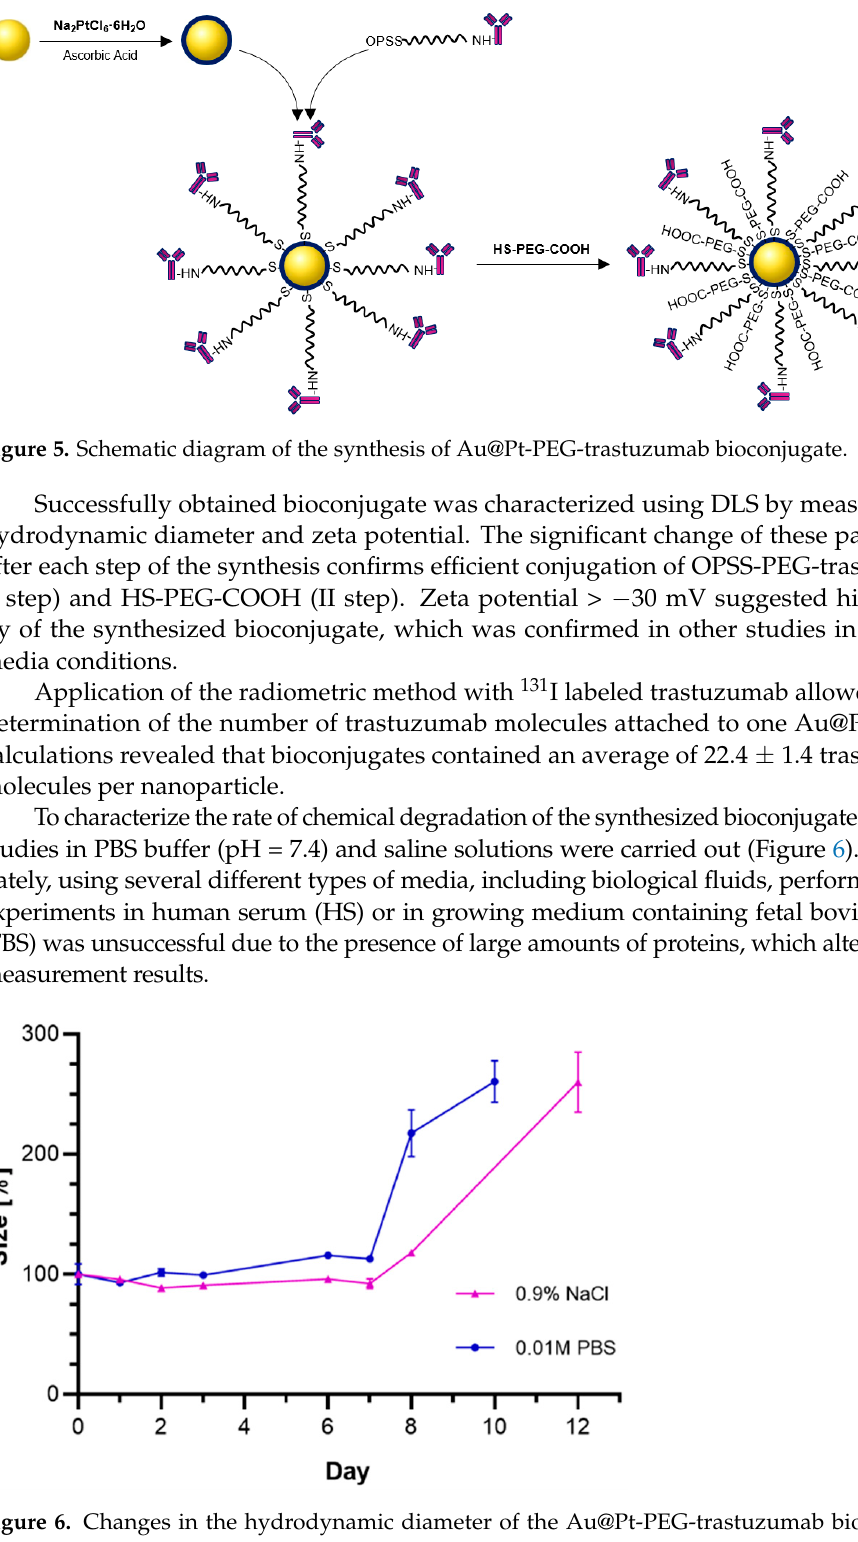
Figure 6. Changes in the hydrodynamic diameter of the Au@Pt-PEG-trastuzumab bioconjugate incubated in 0.9% NaCl and 10 mM phosphate-buffered saline (PBS) buffer at 37 °C.